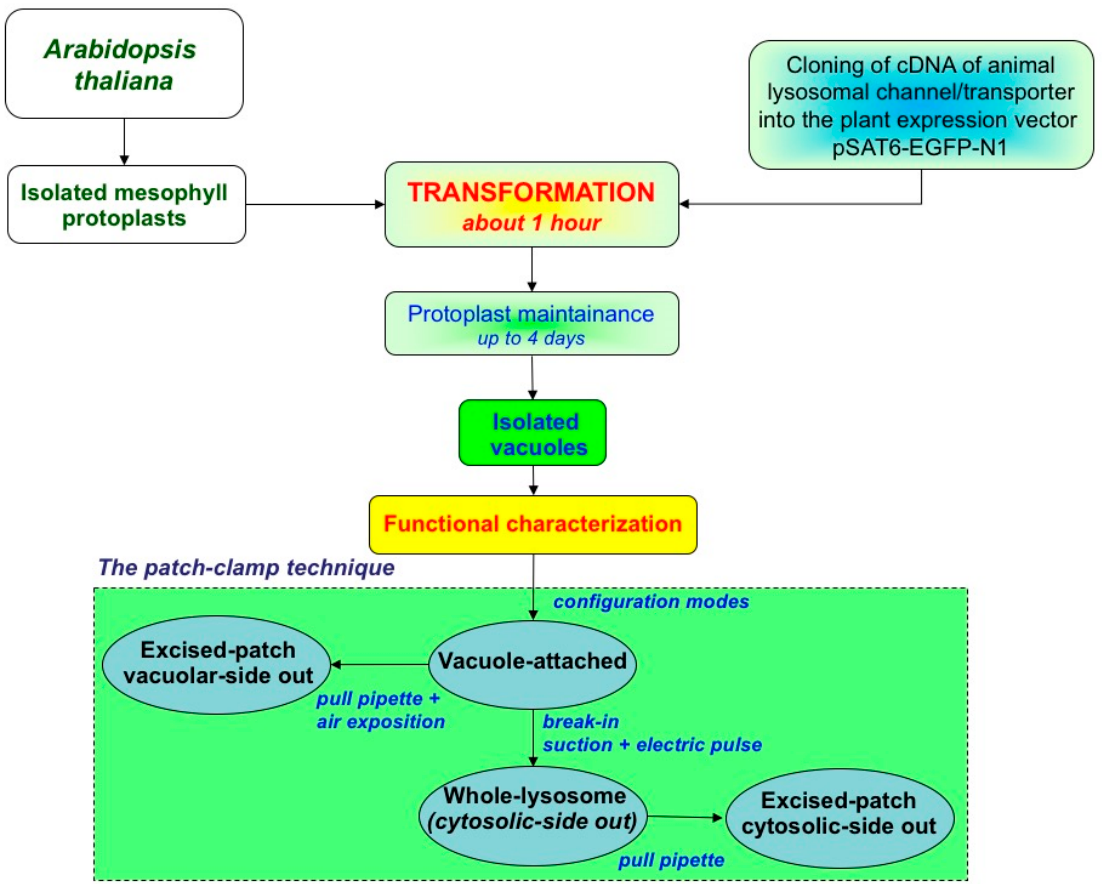
Figure 6. Flow chart of the experimental procedures showing how Arabidopsis vacuoles can be a heterologous expression system for animal lysosomal ion channels and transporters. Transformation can be performed on protoplasts from Arabidopsis wild-type plants or mutants lacking a specific endogenous channels or transporters.